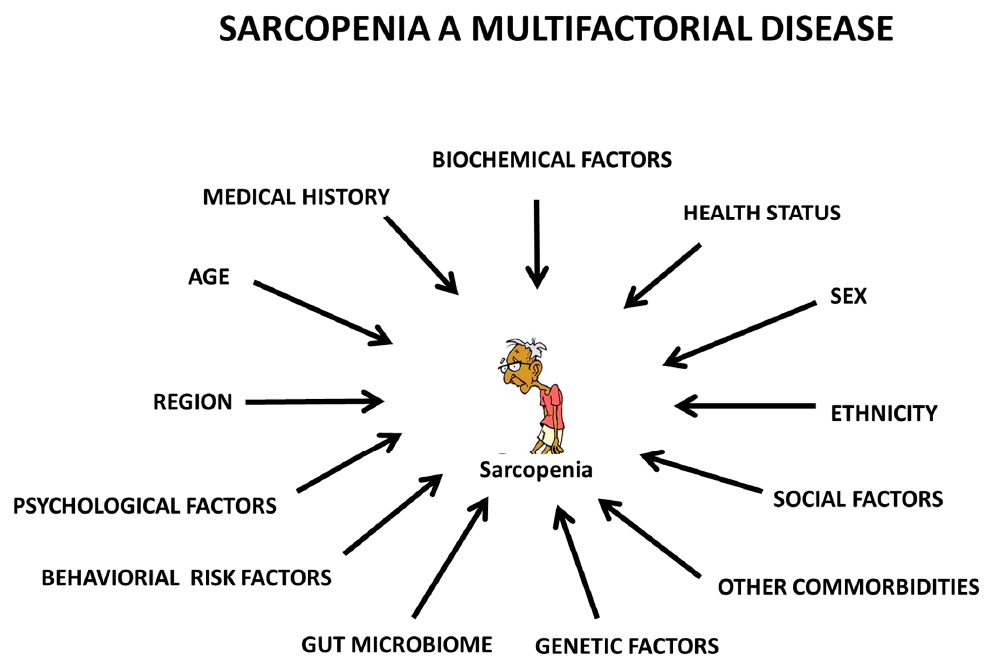
Figure 1. Sarcopenia associated with multiple factors including age, sex, region, ethnicity, medical history, health status, psychological factors, social factors, behavioral factors, gut microbiome, genetic factors, other comorbidities, and biochemical factors.